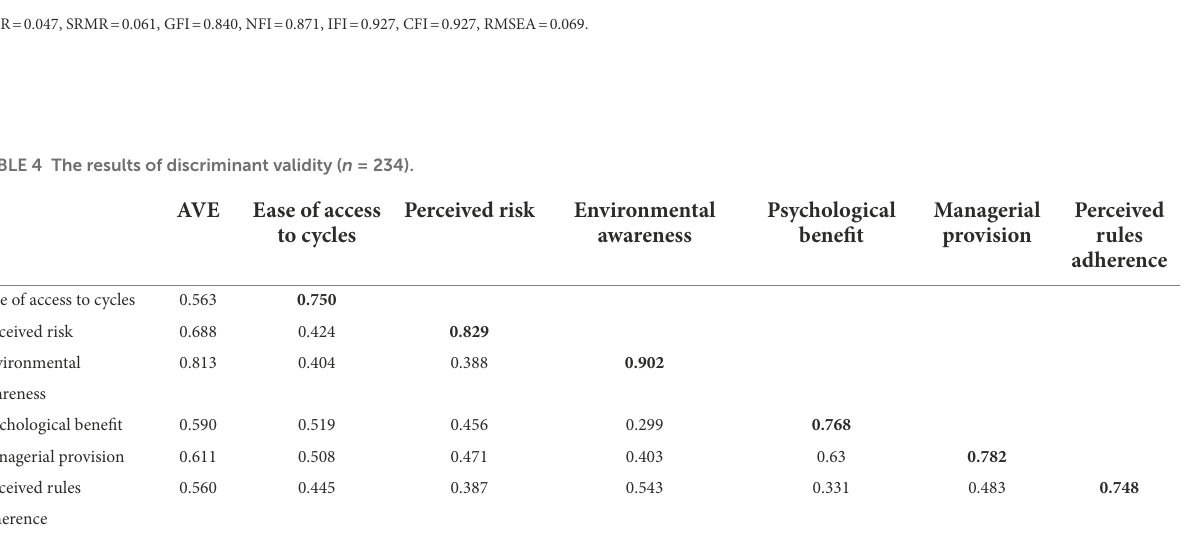
TABLE 4 The results of discriminant validity ( n = 234).